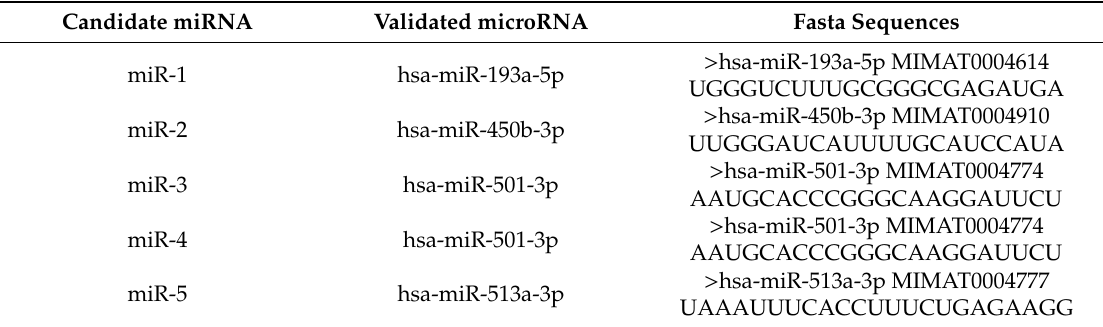
Figure 1. Schematic representation of the methodology. Table 1. MicroRNAs and their